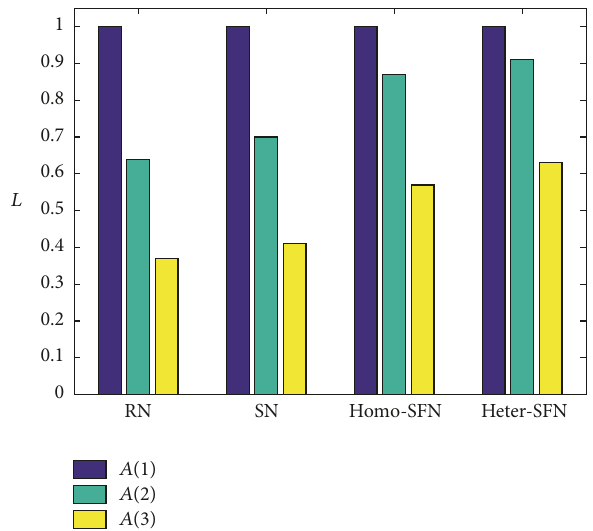
Figure 15: Failure size 𝐿 with varying types of matrix 𝐴 under max- degree attack ( 𝑅 = 2 , 𝜀 = 0.6